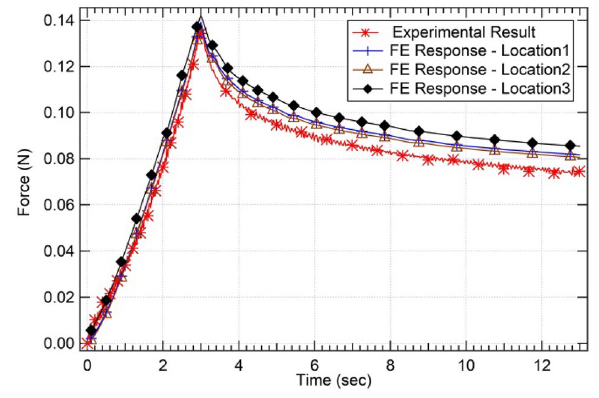
Fig. 10 Force response from 2D and 3D models